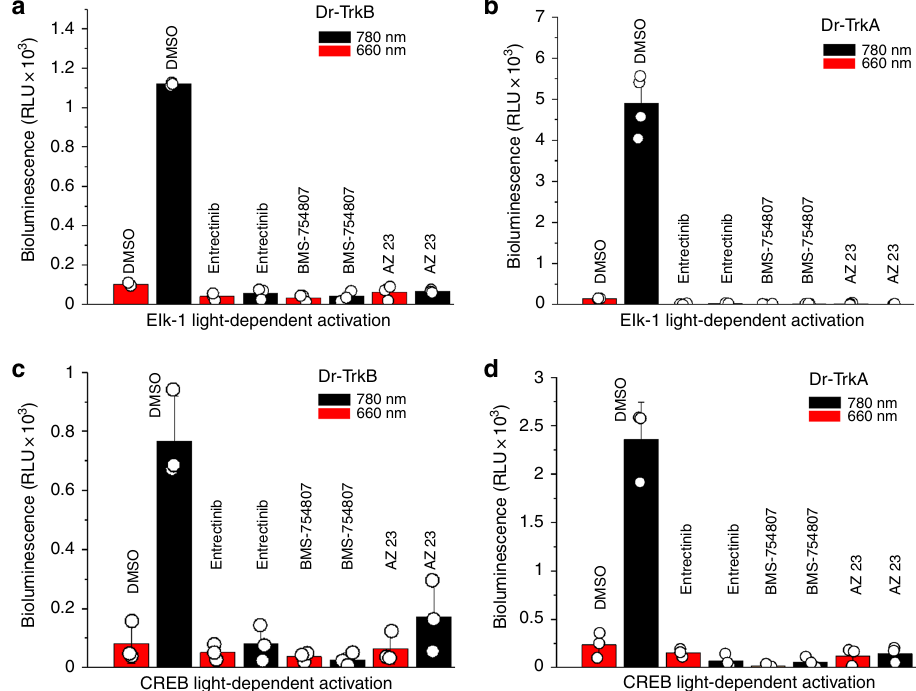
Fig. 3 Downregulation of Dr-Trk activity with FR light and kinase inhibitors. a Luciferase assay for Elk-1-dependent transcription in PC6-3 cells co-transfected with pCMVd2-Dr-TrkB, pFR-Luc, and pFA-Elk-1 plasmid mixture (1:100:5) and grown for 30 h under 660nm or 780 nm light (both 0.5mWcm − 2 ). The indicated kinase inhibitors (100nM) or dimethyl sulfoxide (DMSO) solvent (0.1%) were added to the culture medium. b Luciferase assay for Elk-1-dependent transcription in PC6-3 cells co-transfected with pCMVd2-Dr-TrkA, pFR-Luc, and pFA-Elk-1 plasmid mixture and grown under 660nm or 780nm light. c Luciferase assay for CREB-dependent transcription in PC6-3 cells co-transfected with pCMVd2-Dr-TrkB, pFR-Luc, and pFA-CREB plasmid and grown under 660 nm or 780nm light in the presence of kinase inhibitors. d Luciferase assay for CREB-dependent transcription in PC6-3 cells co-transfected with pCMVd2-Dr-TrkA, pFR-Luc, and pFA-CREB plasmid mixture and grown under 660 nm or 780 nm light in the presence of kinase inhibitors. Error bars represent s.d., n = 3